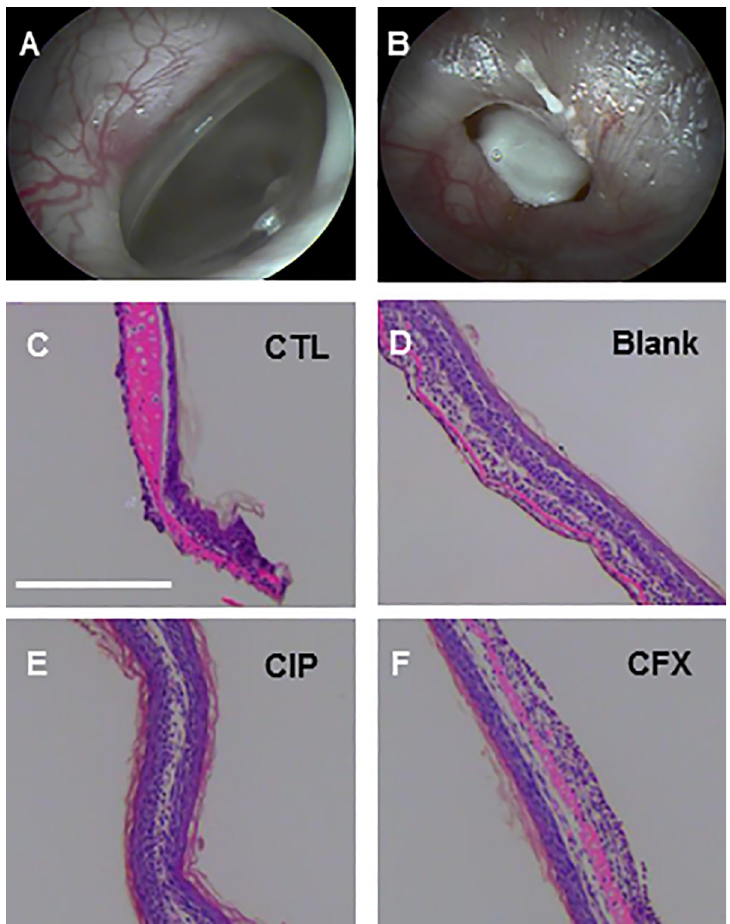
Fig 9. In vivo gel/microsphere (MS) placement and histopathology. Representative images of chinchilla tympanic membrane (TM) before (A) and after (B) gel/MS instillation. Representative hematoxylin and eosin (H&E)-stained sections of excised TMs representing non-treated control (CTL) and TMs treated with blank MS/gel, CIP MS/gel, and CFX MS/gel (C-F) imaged using light microscopy. Scale bar = 20 μ